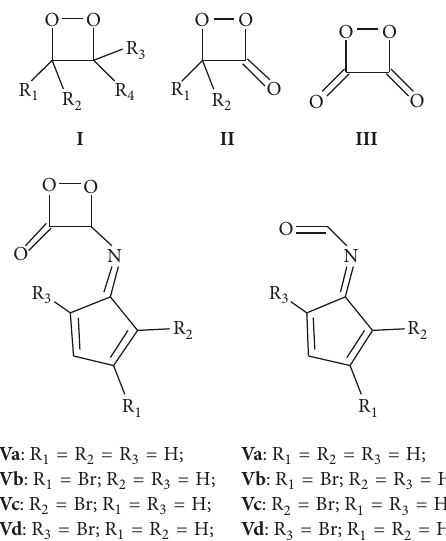
Scheme 1: Schematic representation of dioxetanes (I), dioxetanones (II), dioxetanedione (III), and the model dioxetanone (IV) and its thermolysis product (V) studied